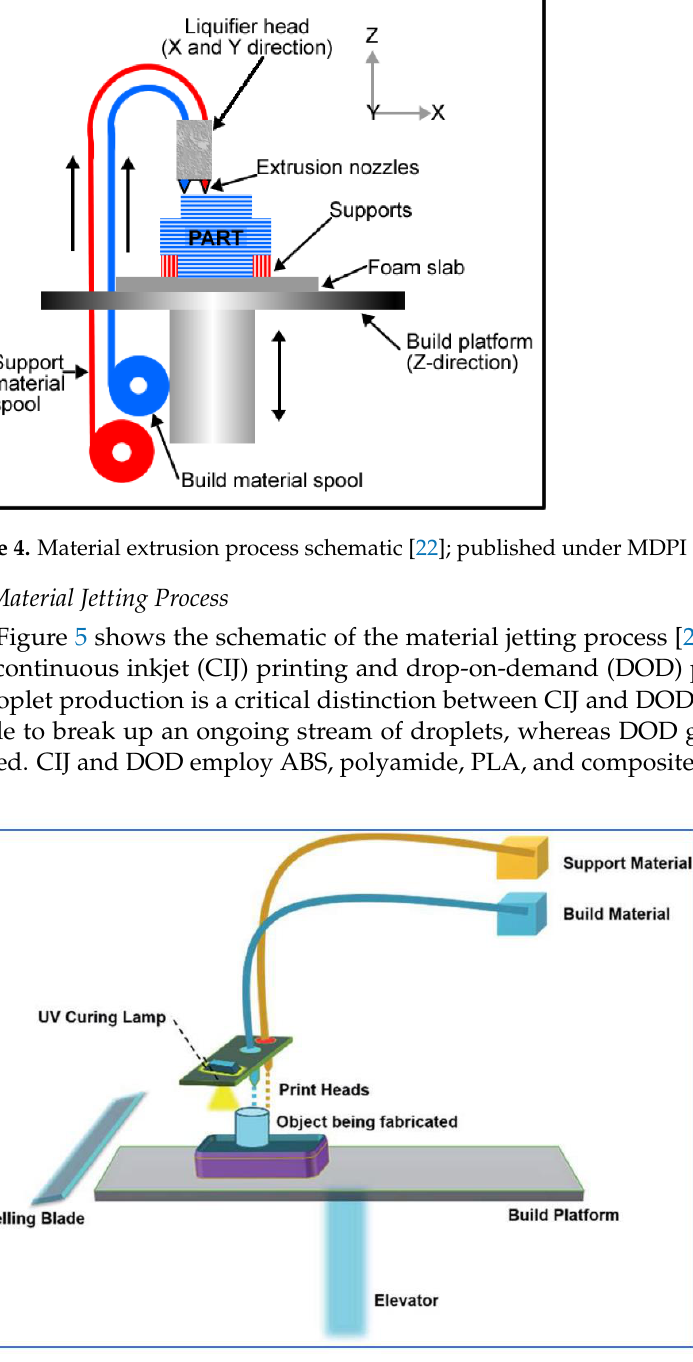
Figure 5. Material jetting process schematic [23]; published under MDPI open-access license.